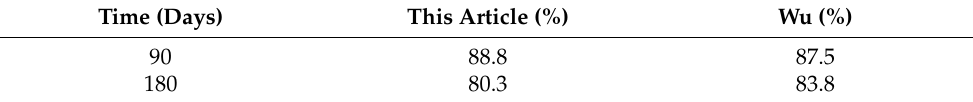
Table 1. Comparison of residual tensile strength between this article and Wu [32] .